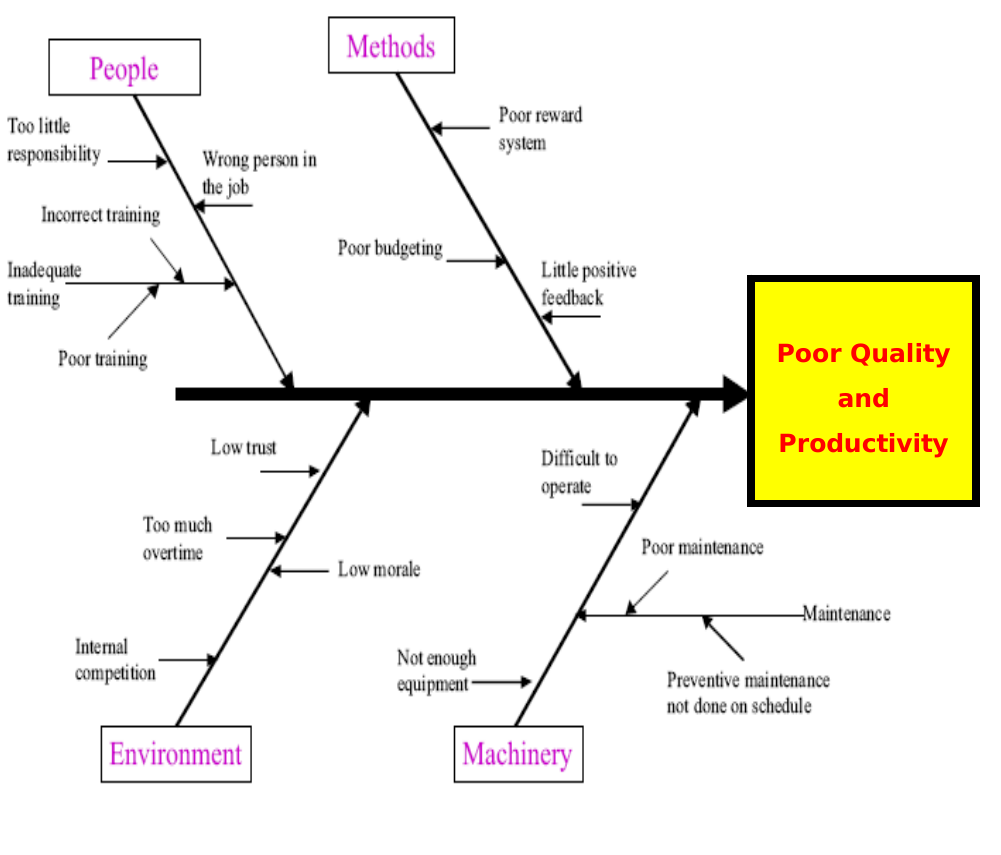
Figure 3. “Cause and effect